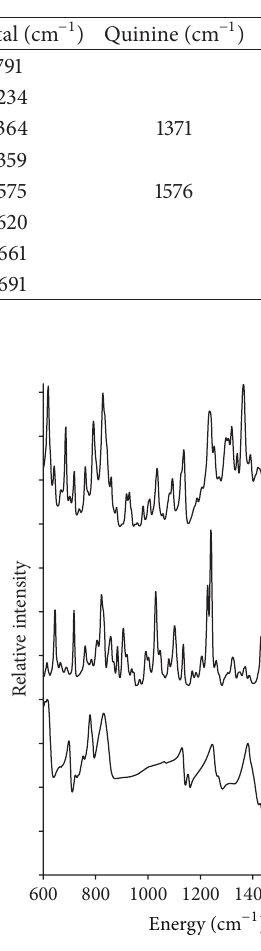
Table 5: Assignments of the major bands in the fingerprint region of the infrared absorption spectra of 5-nitrobarbituric acid, quinine, and their 1: 1 cocrystal product.